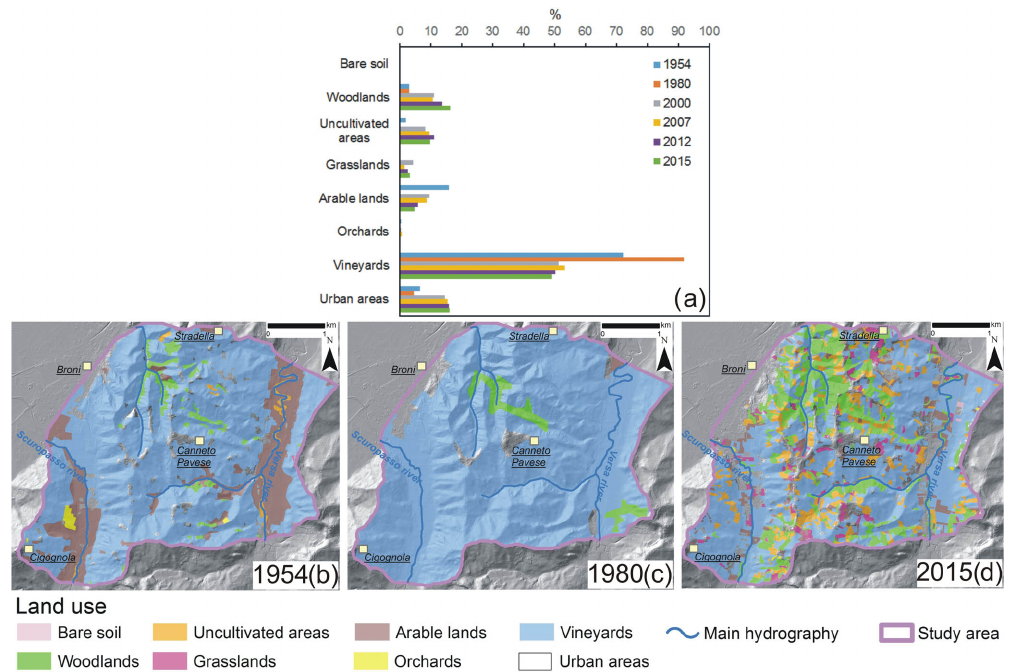
Figure 2. Land use distribution and land use changes in the period 1954–2015: (a) percentage of the area occupied by each land use class during the analyzed period; (b) land use distribution in 1954; (c) land use distribution in 1980 and (d) land use distribution in 2015. Land use maps were provided by the Lombardy Region and shared as part of the Infrastructure for Spatial Information in Lombardy (IIT) via the Geoportal (Lombardy Region Geoportal: http://www.cartografia.regione.lombardia.it/geoportale, last access: 11 December 2017). The detailed information regarding the method to create these maps are available in Fasolini